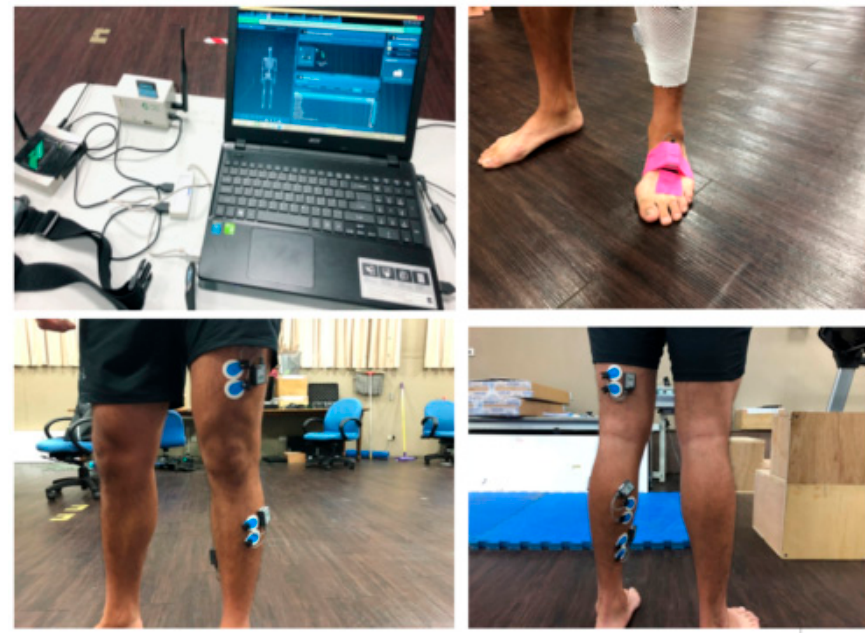
Figure 1. Full set-up position of IMU and EMG sensors.